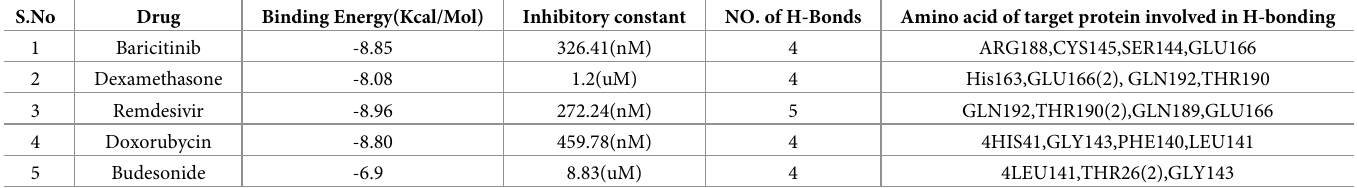
Table 2. Binding energy and drug inhibition constant for docking of drugs with SARS-CoV-2 main protease. S.No